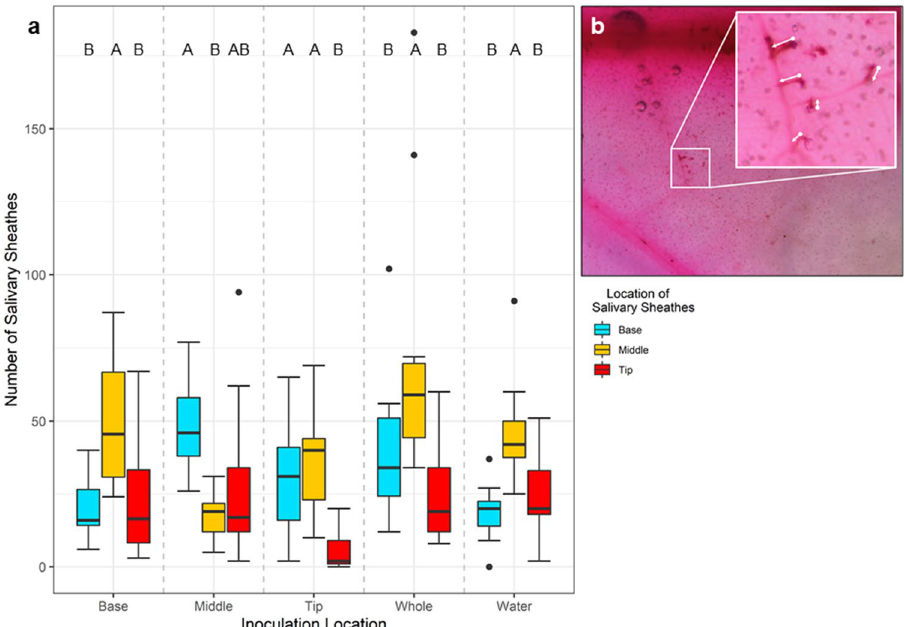
Figure 6. Salivary sheath distribution across tomato leaflets in response to S. enterica inoculations applied to different regions of plants, excluding those found on the primary and secondary veins. Tomato leaflets were inoculated with S. enterica exclusively at the basal, middle or tip regions, or were entirely submerged during inoculation (Whole). Similarly, one group of tomato leaflets were entirely inoculated by water (Water). One hour after S. enterica inoculation, five adult M. quadrilineatus were placed in a container encasing one tomato leaflet still attached to the plant. Leaflets were extracted 72 h post S. enterica inoculation and were subjected to staining and clearing procedures to count total salivary sheaths ( a ). Post clearing and staining procedures, salivary sheathes appeared as dark red in contrast to the pink leaflets ( b ). Salivary sheathes from three experimental replicates (n = 60 leaflets) are combined and represented above. Letters above boxplots indicate significant differences between leaf treatment groups within an insect infestation treatment ( P <